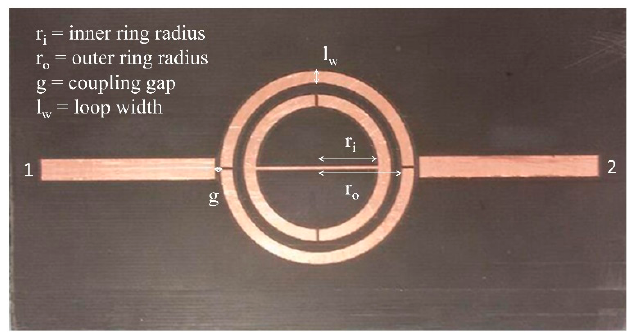
Figure 1. Split ring resonator geometry and its principal parameters.